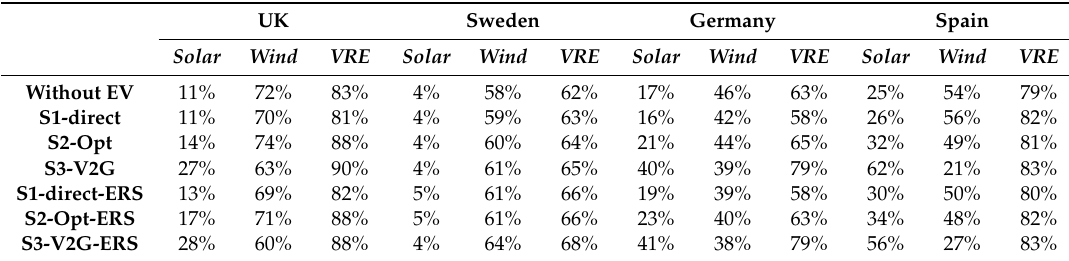
Table 3. Shares of generation from variable renewable electricity (VRE), wind and solar power in Year 2050 in the four countries investigated for the di ff erent scenarios.